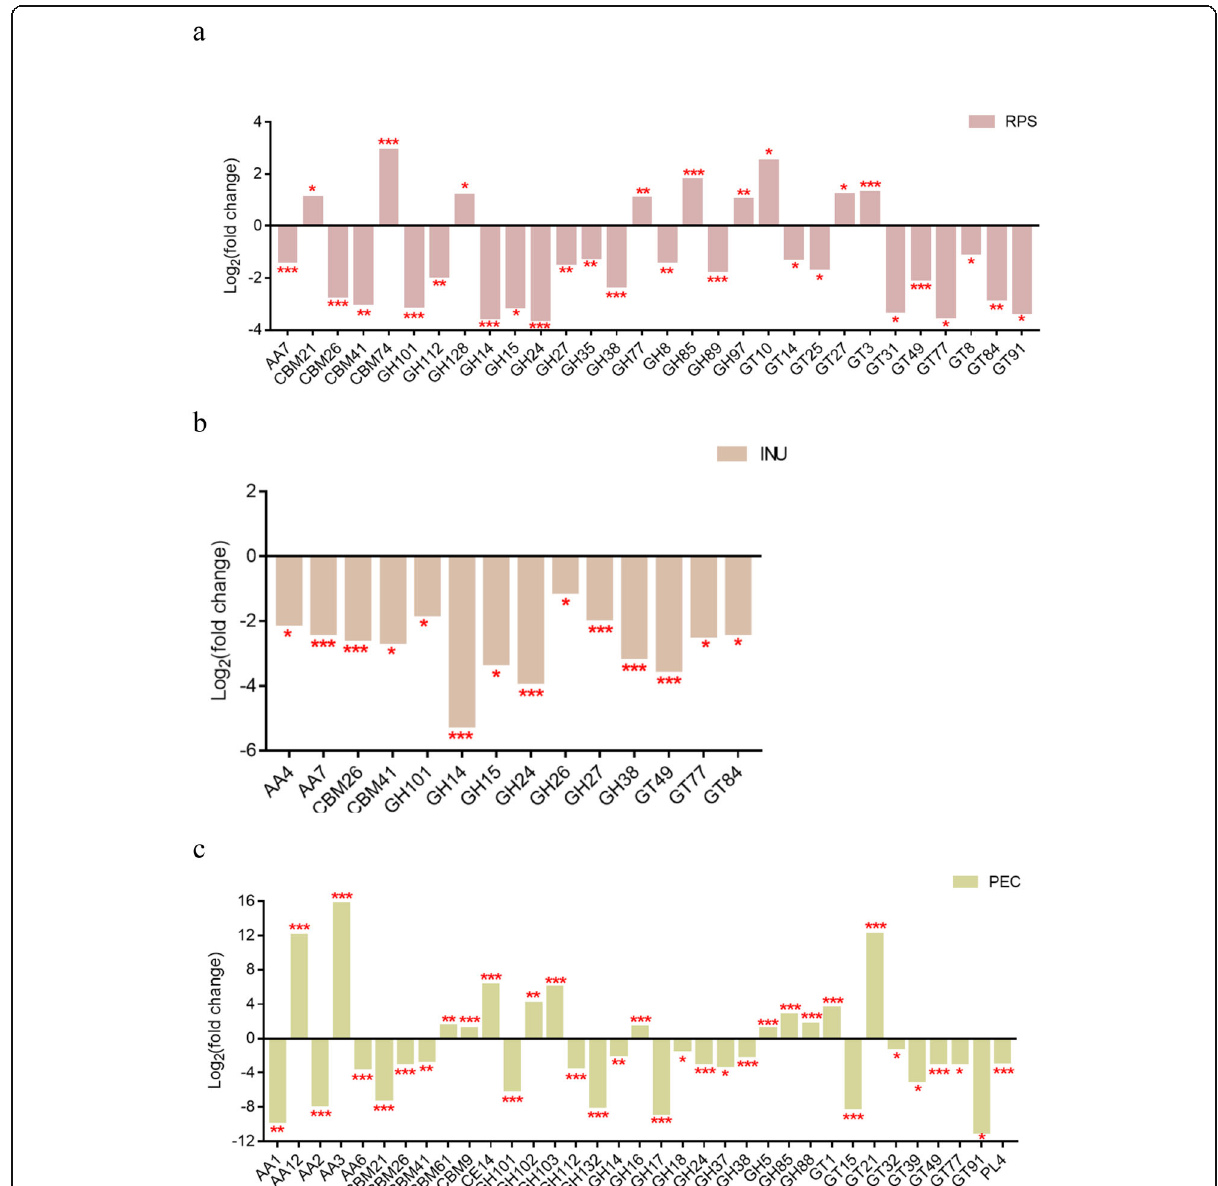
Fig. 6 Gene expression of CAZymes significantly affected by RPS ( a ), INU ( b ) and PEC ( c ) in the pigs ’ colon. The CAZyme families are classified according to the CAZy database. AA, auxiliary activities; CBM, carbohydrate-binding modules; CE, carbohydrate esterases; GH, glycoside hydrolases; GT, glycosyl transferases; PL, polysaccharide lyases. RPS, raw potato starch-enriched diet; INU, inulin-enriched diet; PEC, pectin-enriched diet. The values are presented as log 2 (fold change). The FDR was calculated based on the p -value. *FDR < 0.05, **FDR < 0.01, ***FDR <